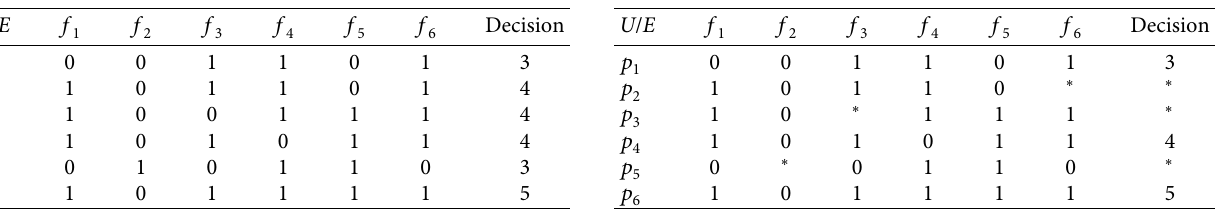
Table 1: Boolean-valued information system. Table 2: Incomplete information system.